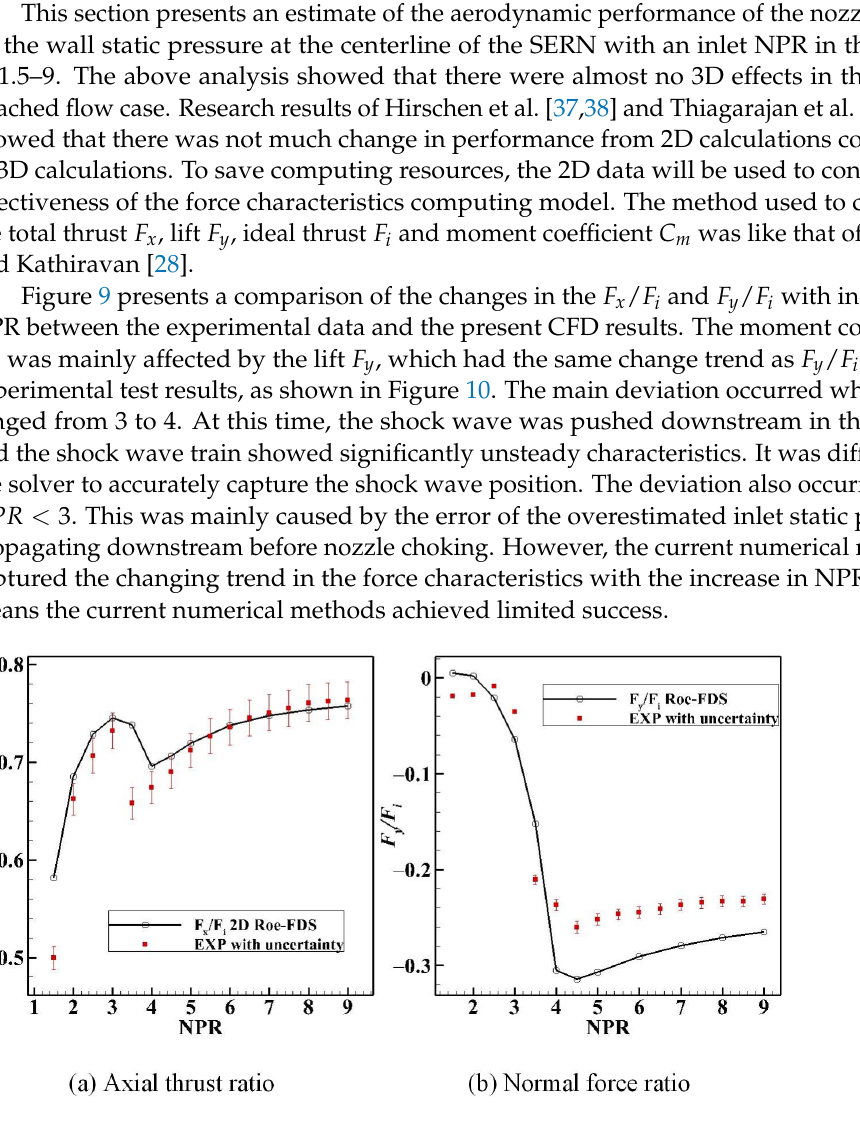
Figure 9. Comparisons of axial thrust ratio and normal force ratio at various NPR